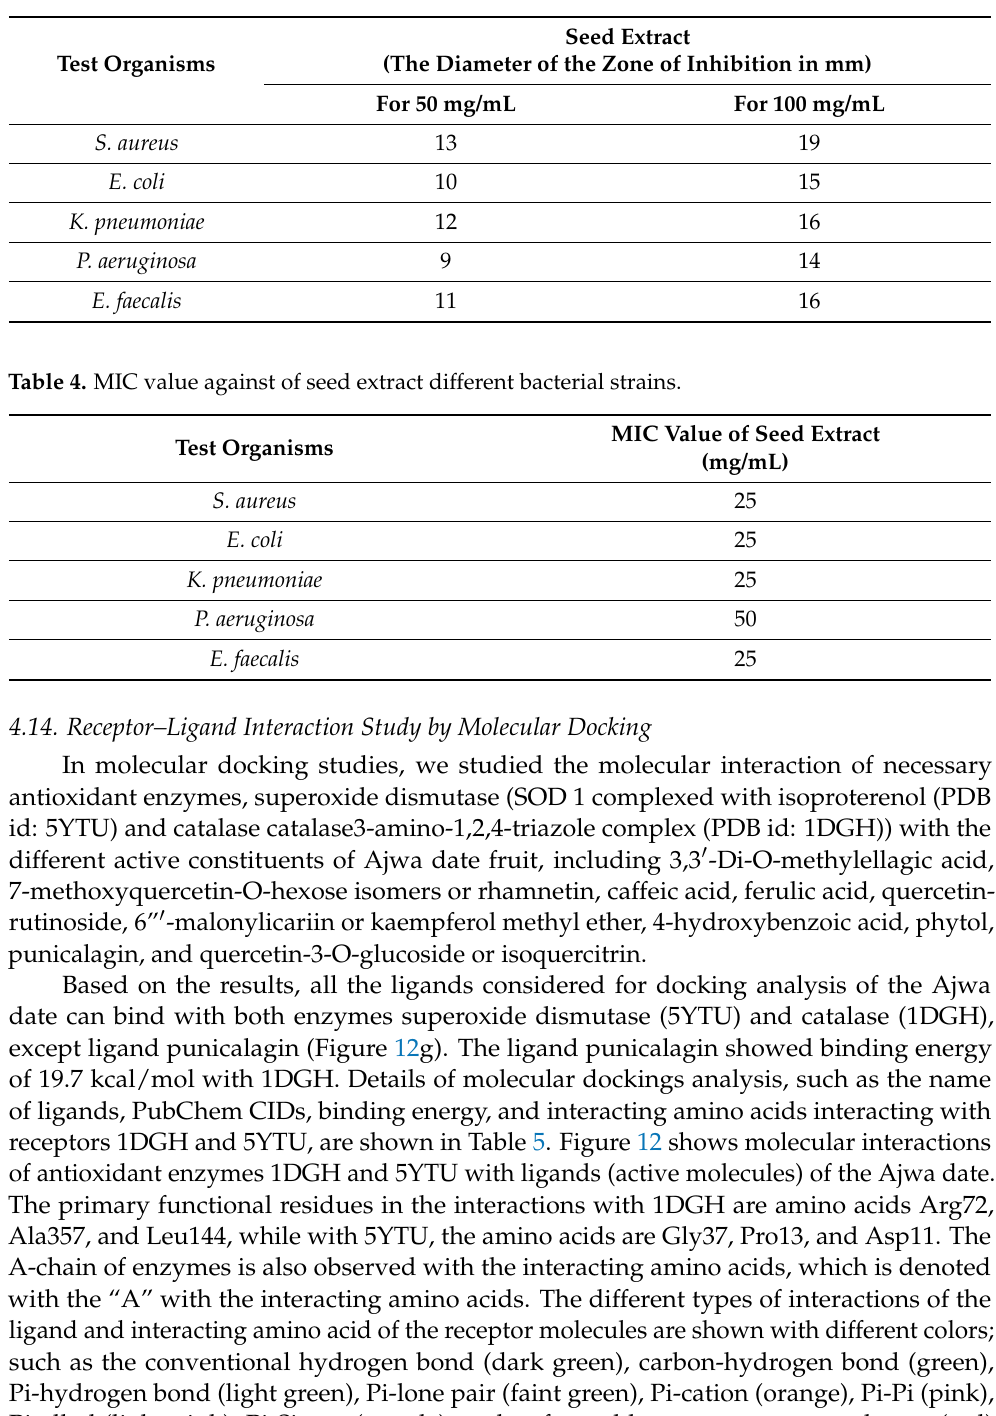
Table 3. Zone of inhibition against different bacterial strains in the presence of seed extract. Seed Extract Test Organisms (The Diameter of the Zone of Inhibition in mm) For 50 mg/mL For 100 mg/mL